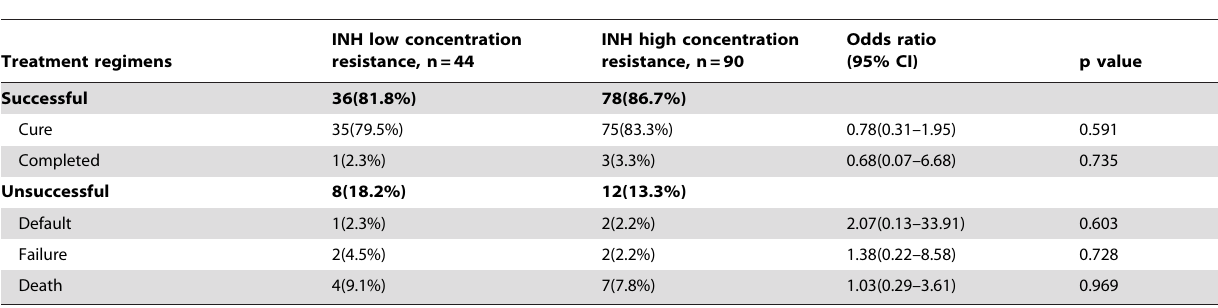
Table 4. Clinical outcomes of the tuberculosis patients with INH monoresistance.